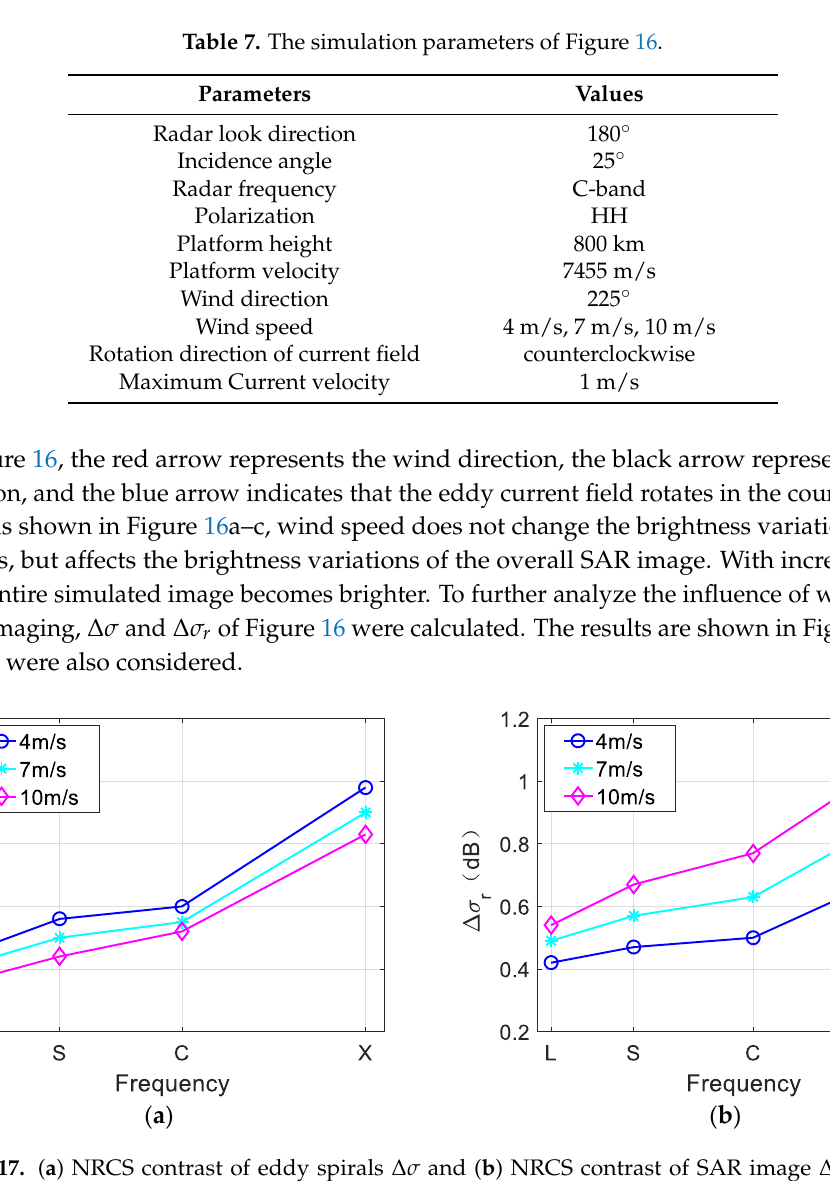
Figure 17. ( a ) NRCS contrast of eddy spirals  and ( b ) NRCS contrast of SAR image under different wind speeds and radar frequencies. Fifty simulations are averaged to reduce speckle